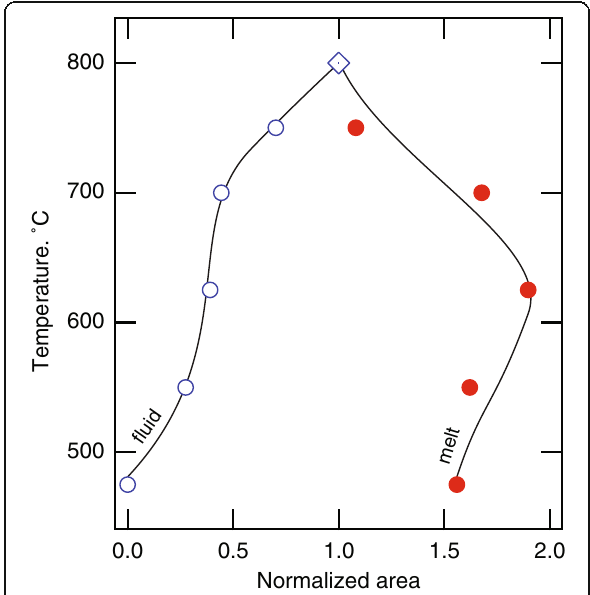
Fig. 9 Evolution of CO 32 abundance in coexisting fluid and melt as a function of temperature and pressure with concentration, expressed as area of the ~ 1070 cm − 1 band normalized to the value for single phase fluid at 800 °C (diamond